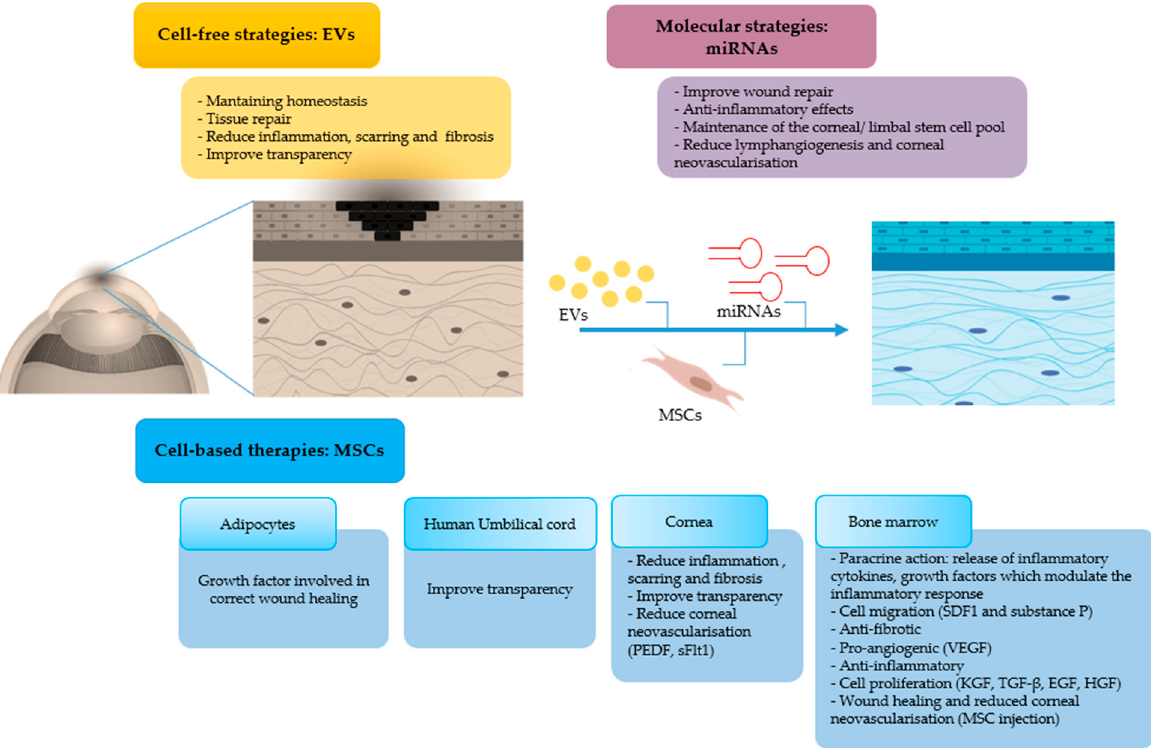
Figure 7. Mechanism of action of MSCs and their derivatives, in particular EVs and miRNAs, on the resolution of corneal burns (MSCs: mesenchymal stem cells, EVs: extracellular vesicles, miRNAs: microRNAs, PEDF: pigment epithelium derived factor, sFlt-1 soluble fms-like tyrosine kinase-1, VEGF: vascular endothelial growth factor, TGF: transforming growth factor, EGF: epidermal growth factor, HGF: hepatocyte growth factor, KGF: keratinocyte growth factor, SDF: stromal cell-derived